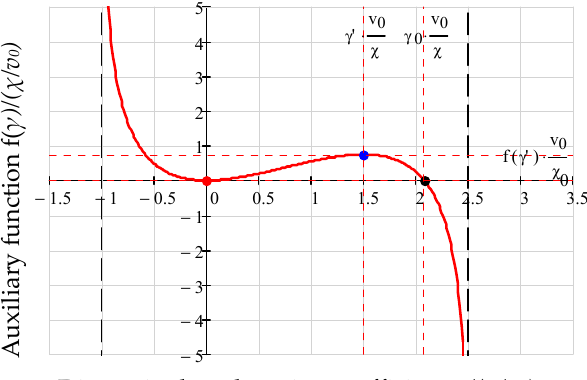
Figure 3. Finding the damping coefficient via numerical method.